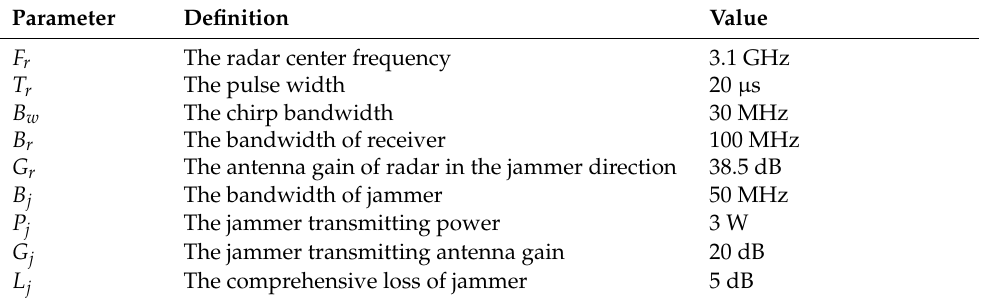
Figure 6. The ECM scenario based on UAV swarm. Table 1. Simulation parameters with their